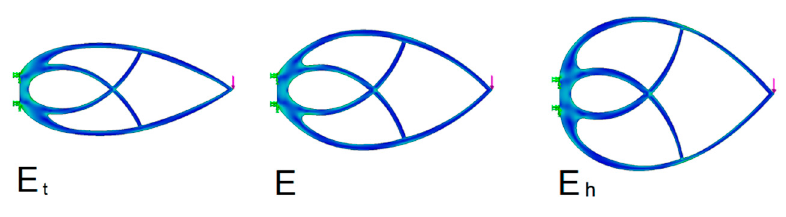
Figure 16. Trusses with a varying k parameter. Table 4. Comparison of trusses of varying slenderness with one support.